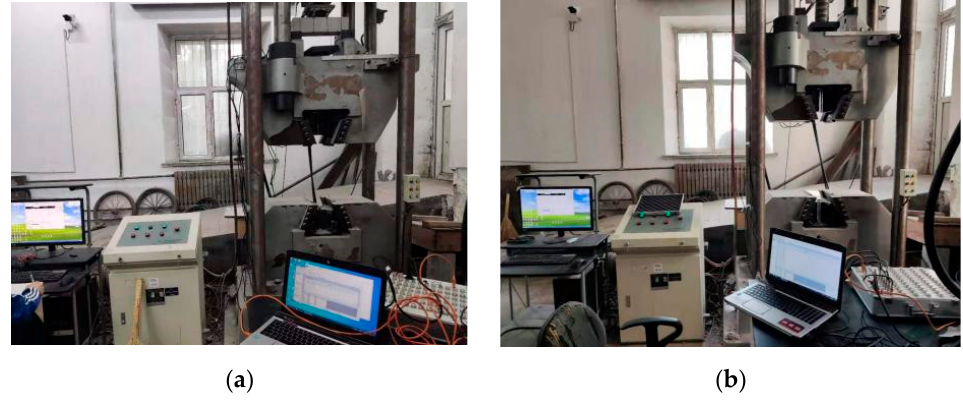
Figure 4. Mechanical test: ( a ) flexural test; ( b ) compressive test.